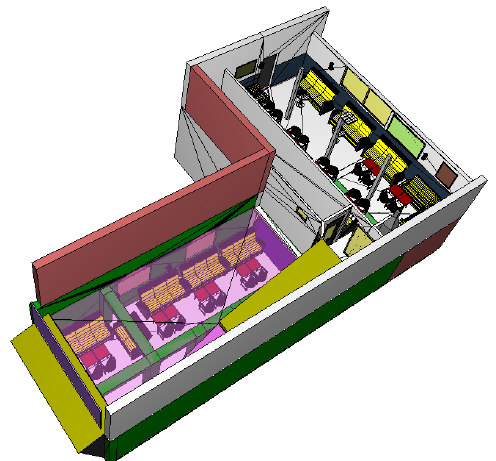
Figure 1. General plan: Ground floor and first floor.